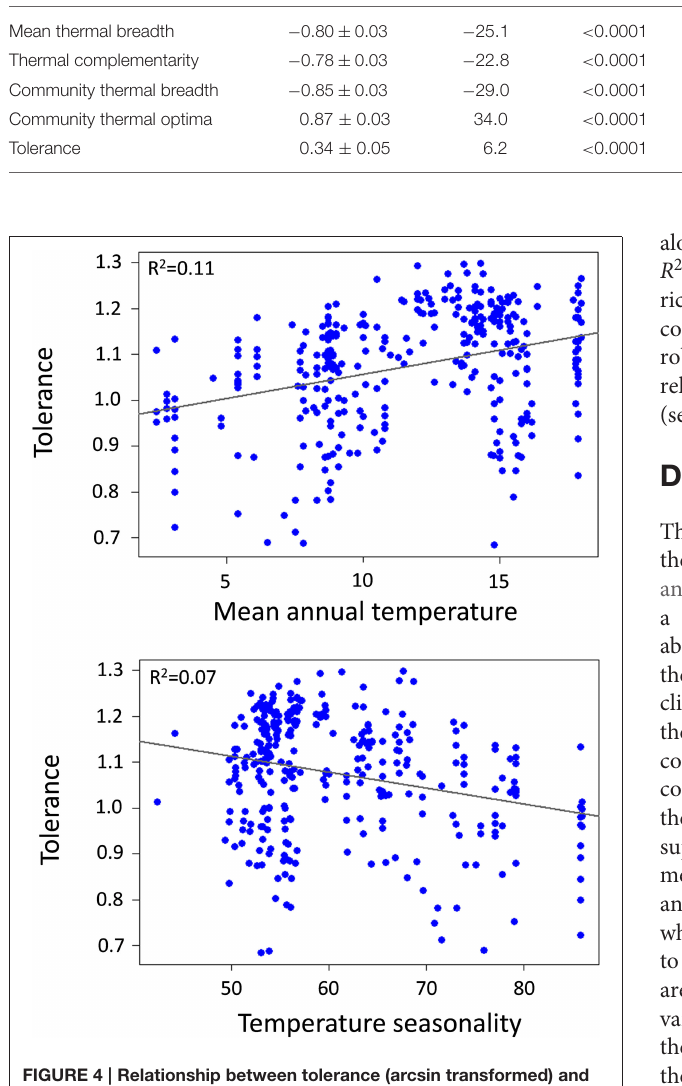
FIGURE 4 | Relationship between tolerance (arcsin transformed) and mean annual temperature (MAT, ◦ C) and temperature seasonality (TS, standard deviation of